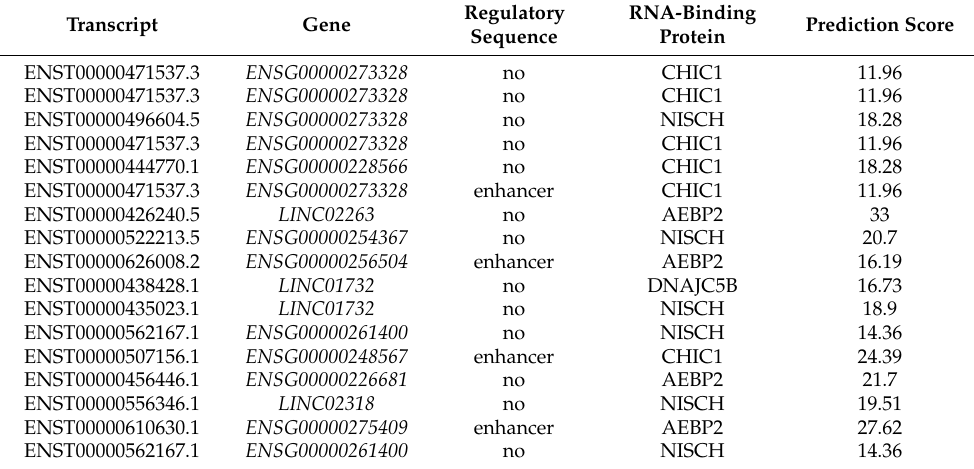
Table 4. LncRNA transcripts complementary to syncytin-2 gene that were predicted to